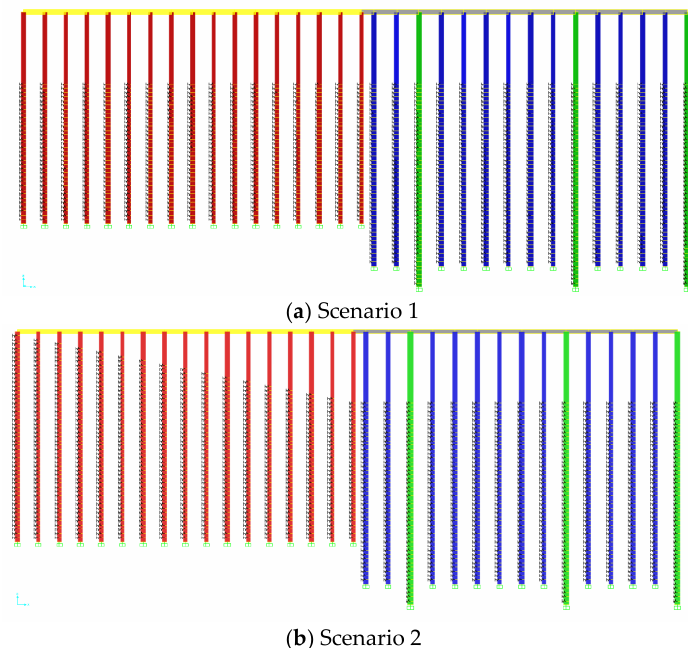
Figure 5. Typical FA model of the PSW.